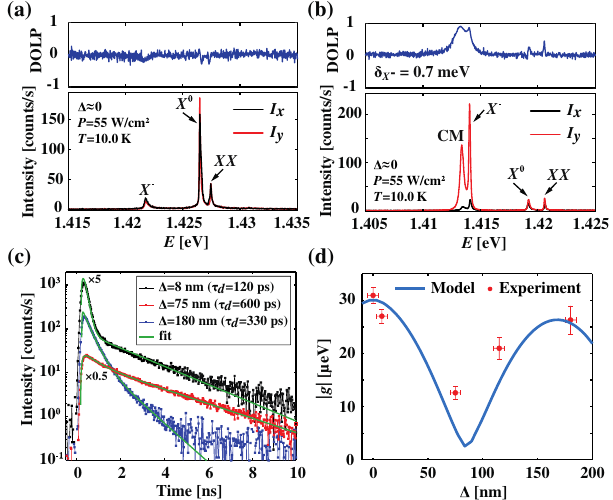
FIG. 2. (a),(b) Polarization-resolved PL (bottom) and corre- sponding DOLP (top) spectra of excitons emitting inside the photonic band gap and near the resonance with CM. (c) X − decay traces measured at X − -CM resonance for different Δ . (d) X − -CM coupling strength g versus Δ extracted from the X − radiative decay rates at the X − -CM